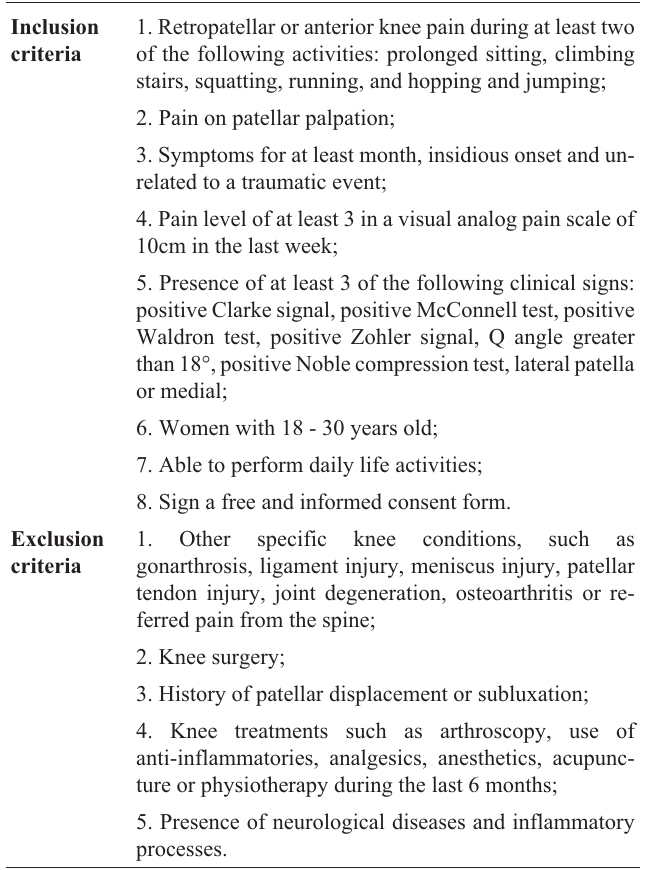
Table 1 - Inclusion and exclusion criteria 14